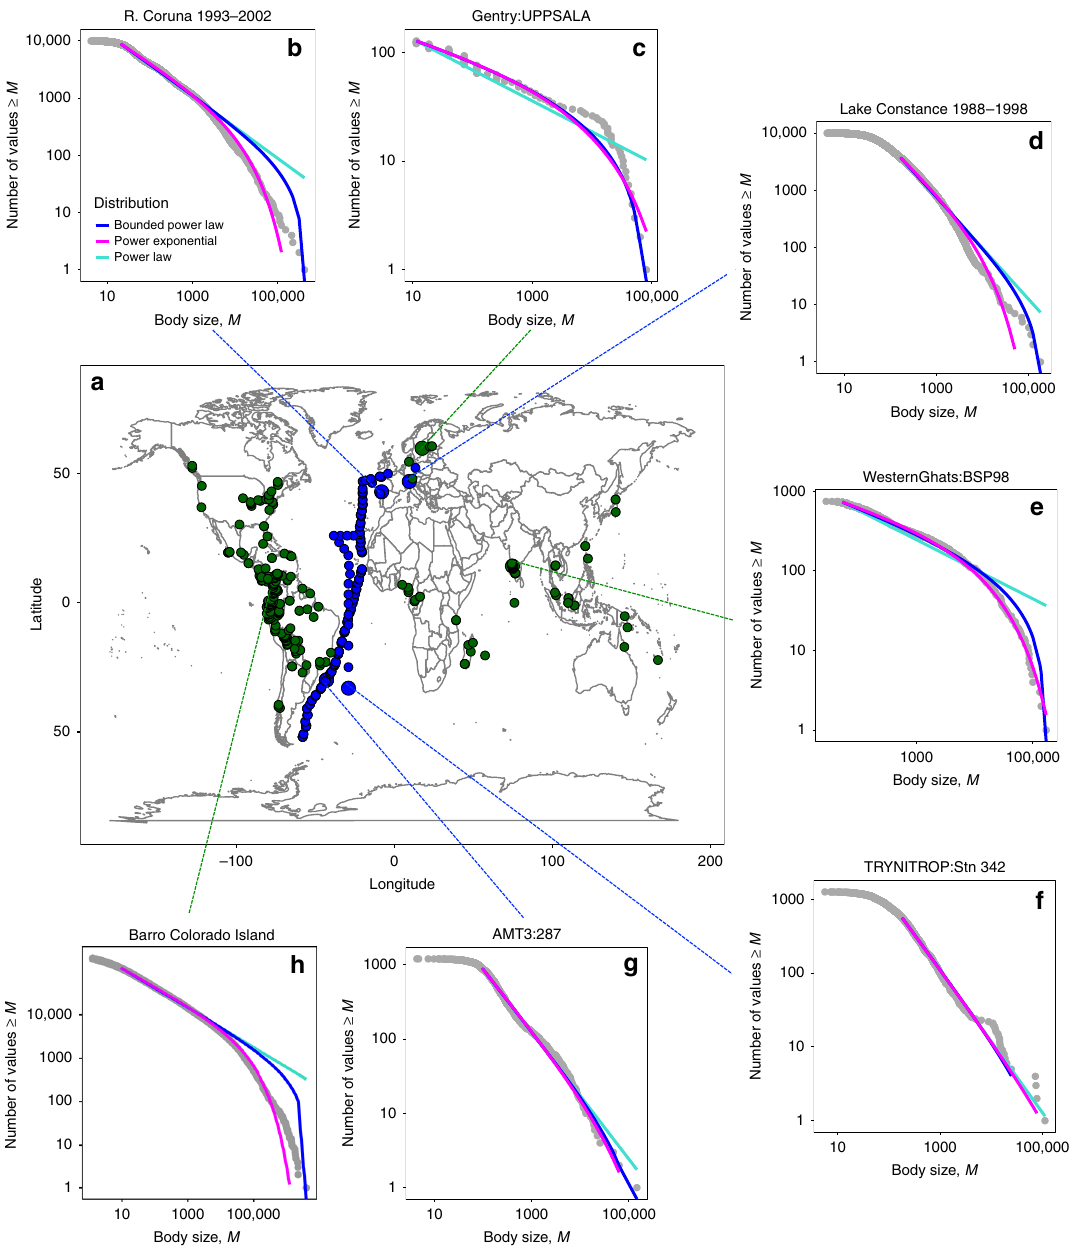
Fig. 1 Global distribution of survey sites including representative individual size distributions. a Green and blue data points denote terrestrial and aquatic sampling locations, respectively. b – h A subset of rank-frequency plots which gives, on log 10 axes, the rank of body size, M , ( μ m 3 for phytoplankton and D 8/3 for trees, where D is tree stem diameter in cm) and the number of values ≥ M . The bounded power-law (blue fi tted line) was generally the best- supported distribution for both tree and phytoplankton communities (Table 1), out-performing the (unbounded) power-law or power-exponential distributions (turquoise and magenta fi tted lines,